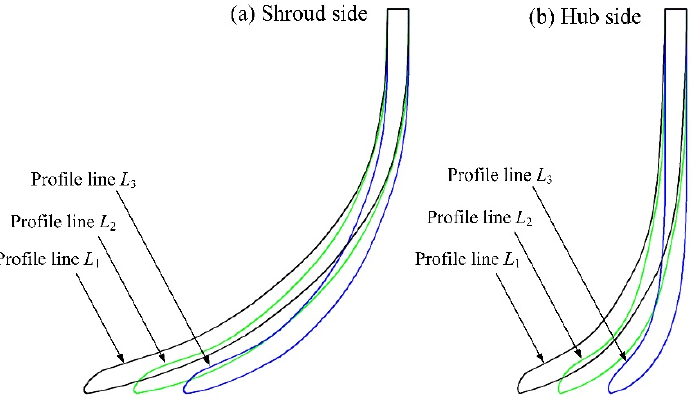
Figure 4. Schematic diagram of the profile line L of the axial cascade. ( a ): profile line L on the shroud side and ( b ): on the hub